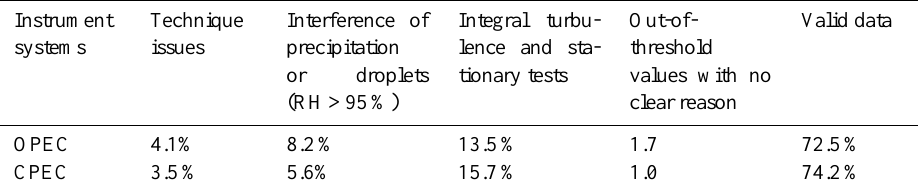
Table 1. Data coverage of water vapor flux data from the open- and closed-path eddy covariance system recorded in the observation year of 2003 at the Changbai Mountains forest flux site. Technical issues include power failure, equipments maintenance and calibration. The stationarity test filtered out flux data calculated for a 30min interval deviate more than 30% from the mean of the covariance of 5min subperiods (Foken and Wichura,